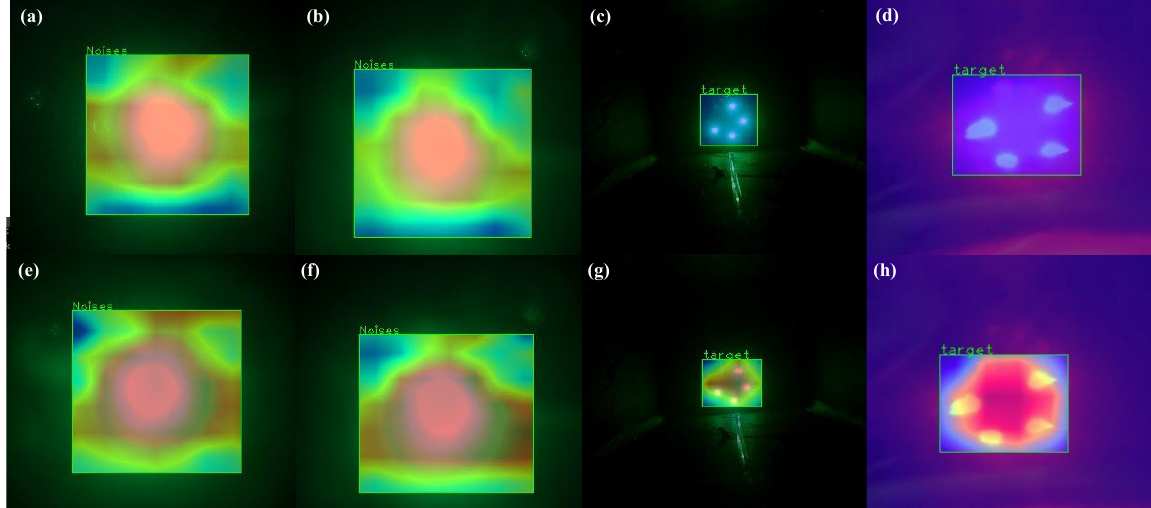
Figure 12. Heat maps: ( a – d ) are heat maps of YOLO V5n; ( e – h ) are heat maps of YOLO V5_CA.